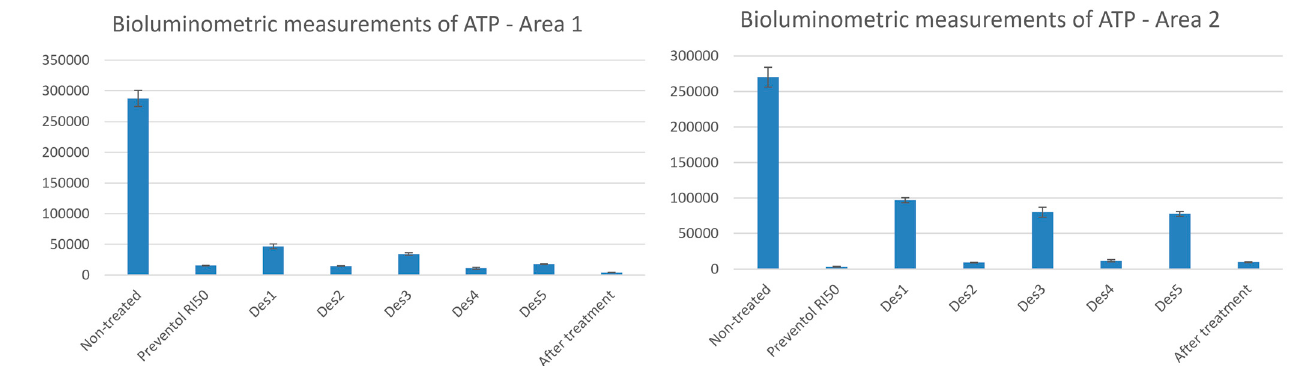
Figure 2. Bioluminometric measurements of ATP of the areas of interest. The values of RLU and SD are reported for Area 1 and Area 2 comparing them to the non ‐ treated and the mechanically and chemically treated areas.